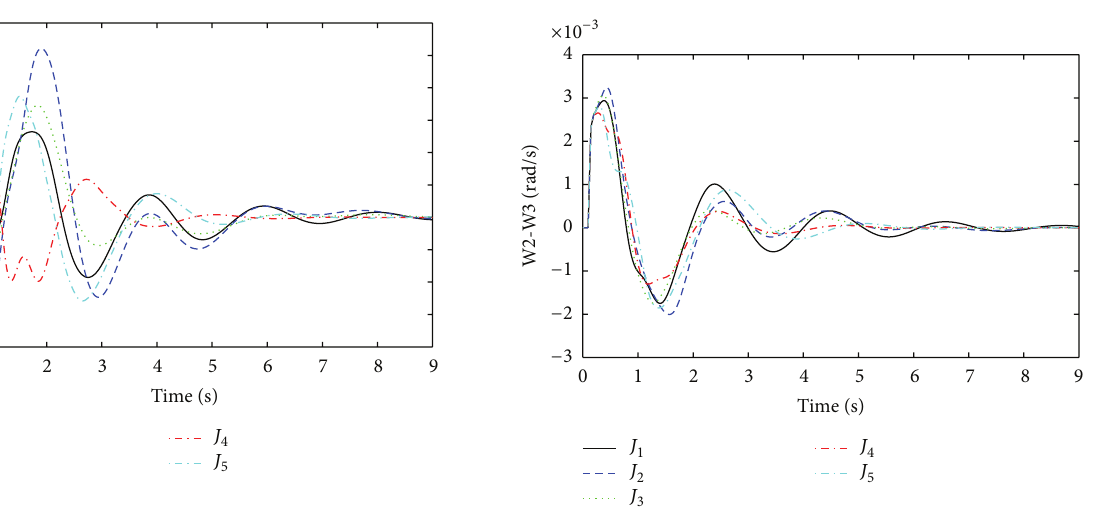
Figure 10: Interarea mode of oscillations between G2 and G3 (W2- W3) for three-phase fault at bus